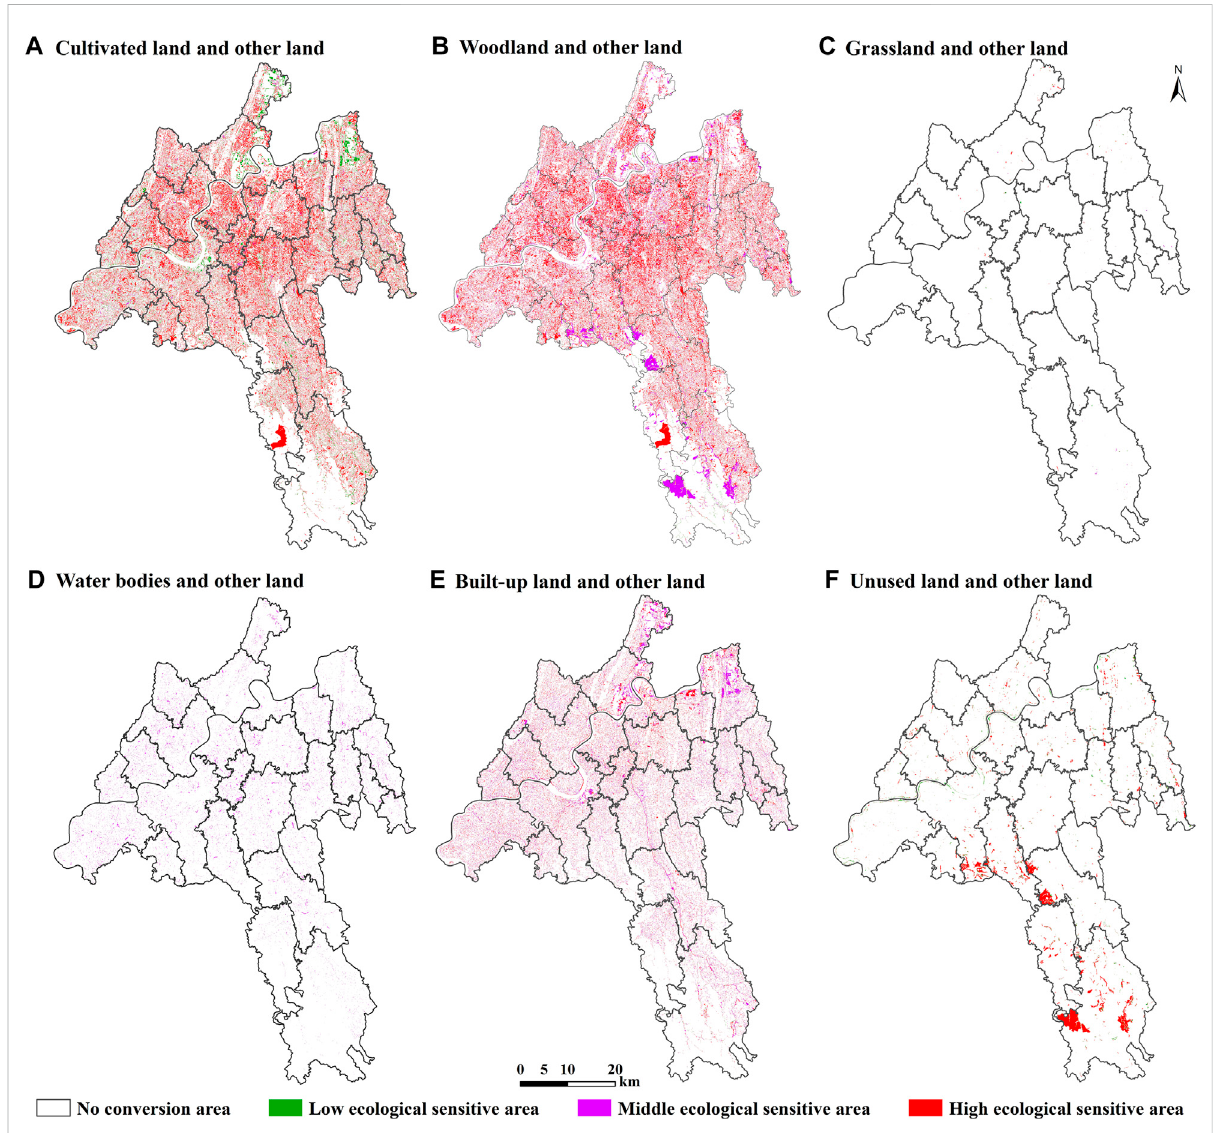
FIGURE 9 Cross-sensitivity zoning of ecosystem service value in Jiangjin from 2009 – 2019. (A – F) represent the cross-sensitivity zoning of cultivated land andotherland,woodland andotherland, grassland andotherland, water bodiesandotherland,built-uplandand otherland,unusedlandand other land,